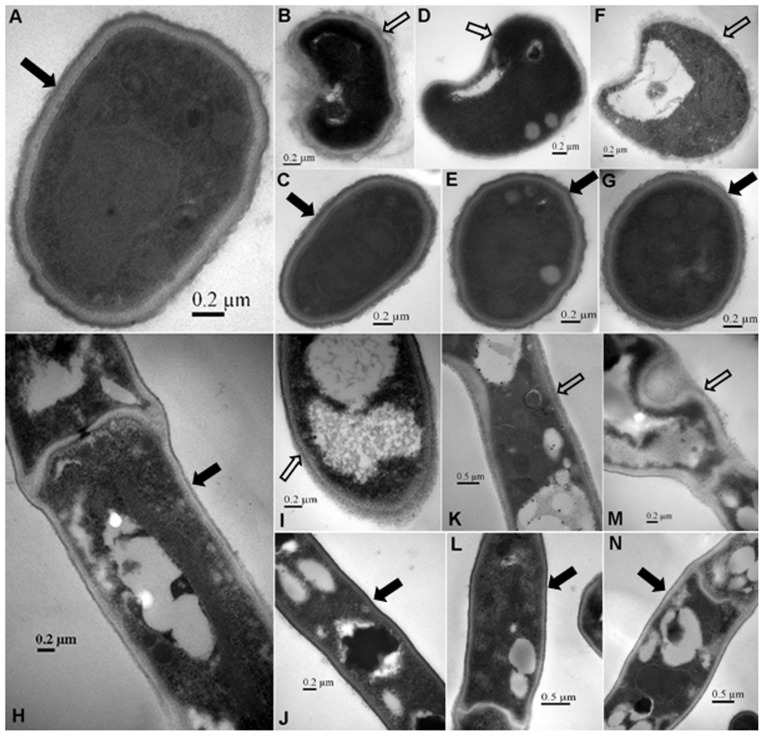
TEM images of B. bassiana conidia (A–G) and hyphal cells (H–N).Note the cell wall impairments (open arrows) of conidia and hyphal cells (I, K and M) in Δbck1 (B and I), Δmkk1 (C and K) and Δslt2 (D and M), compared to an outermost electron-dense layer and a distinctly outlined membrane (solid arrows) in the counterpart cells of wild type (A and H) and three targeted gene complementation mutants (C–G, J, L and N).